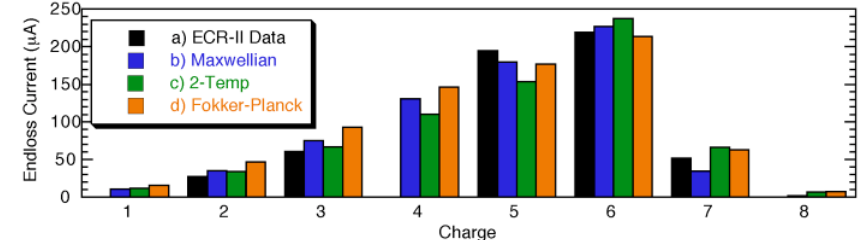
FIG. 2. (Color) Comparison of modeling results with ANL-ECRII Faraday cup measurements.